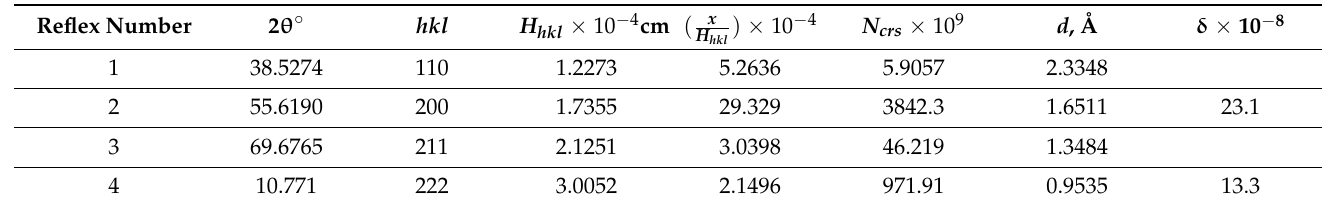
Table 1. Experimental data on X-ray diffraction and results of quantitative calculations for polished tantalum